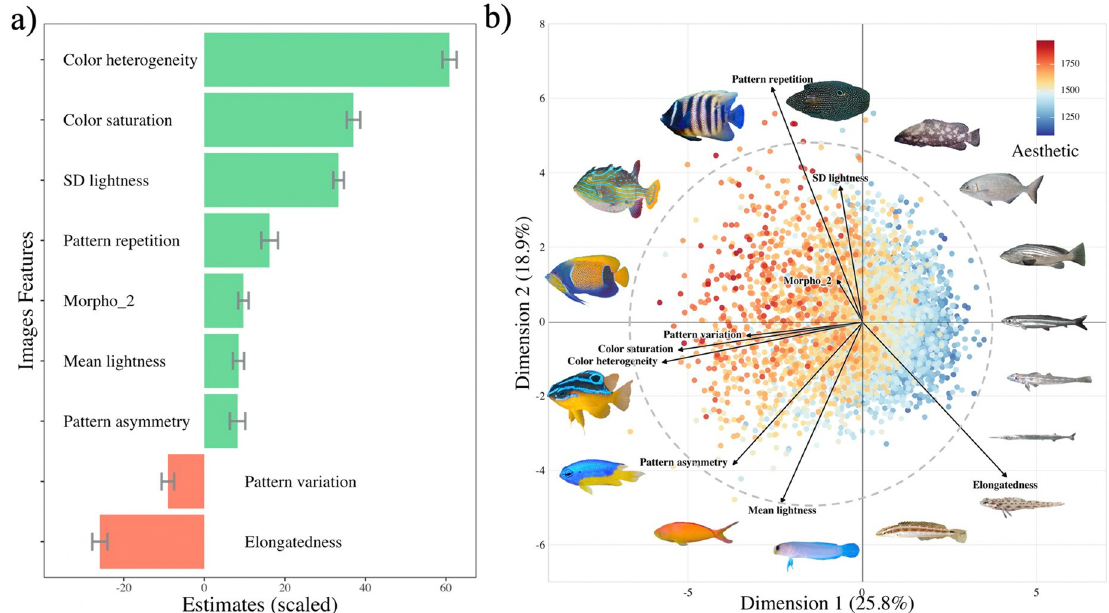
Fig 2. Image features analysis. (a) Regression coefficients (with standard errors) from the final model between the aesthetic value and the 9 significant image features (see Text A in S1 File for a complete description of the image features). The variables have been scaled to visualize how the magnitude of the effects differs between them. Most important variables were: color heterogeneity, color saturation, standard deviation in lightness (SD lightness), pattern repetition, and body elongatedness. (b) Principal Component Analysis (PC1 and PC2) performed with the 9 significant images features (see Fig 2A, Text A, F in S1 File for a description of the image features). Points (fishes) are colored by their aesthetic values, and image feature vectors are projected on the 2 axes. Examples of fishes (chosen on the perimeter of the distribution) are provided for illustration. Clockwise order: Calloplesiops altivelis , Epinephelus ongus , Kyphosus vaigiensis , Epinephelus costae , Jenkinsia lamprotaenia , Phyllogobius platycephalops , Belone belone , Ctenogobiops crocineus , Suezichthys devisi ,